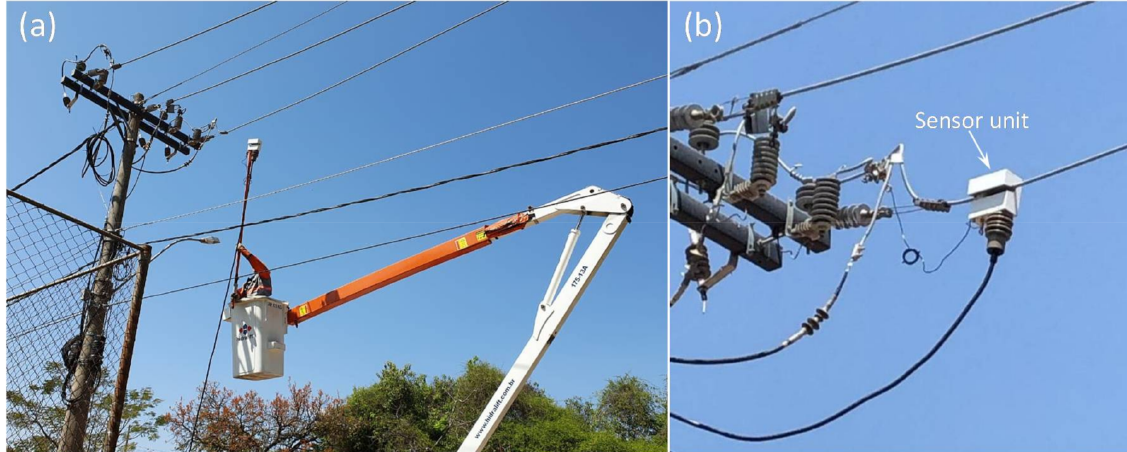
Figure A3. ( a ) Sensor has been installed in a covered cable using a fiberglass hot stick and an aerial lift and ( b ) sensor in the conductor.